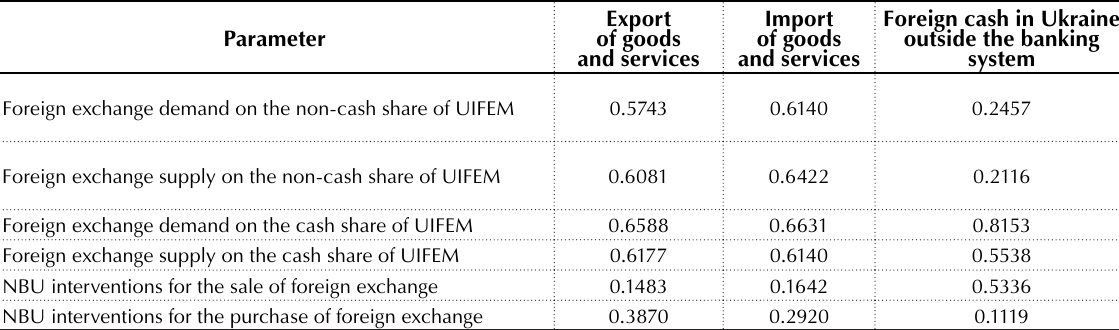
Table 1. The correlation matrix of the Ukrainian interbank market, external sector selected indicators within 2007–2016